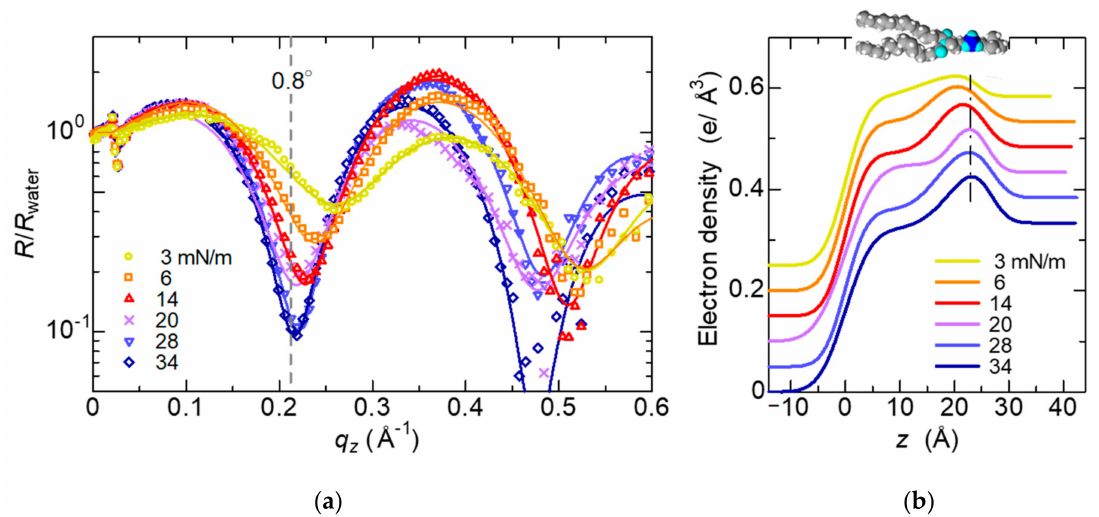
Figure 5. ( a ) X-ray reflectometry curves of DSPC films divided by that of water. ( b ) Electron density profiles corresponding to the fits of the reflectometry curves. For clarity, data sets are shifted vertically. The peaks originate from the phosphor group of DSPC penetrated in the